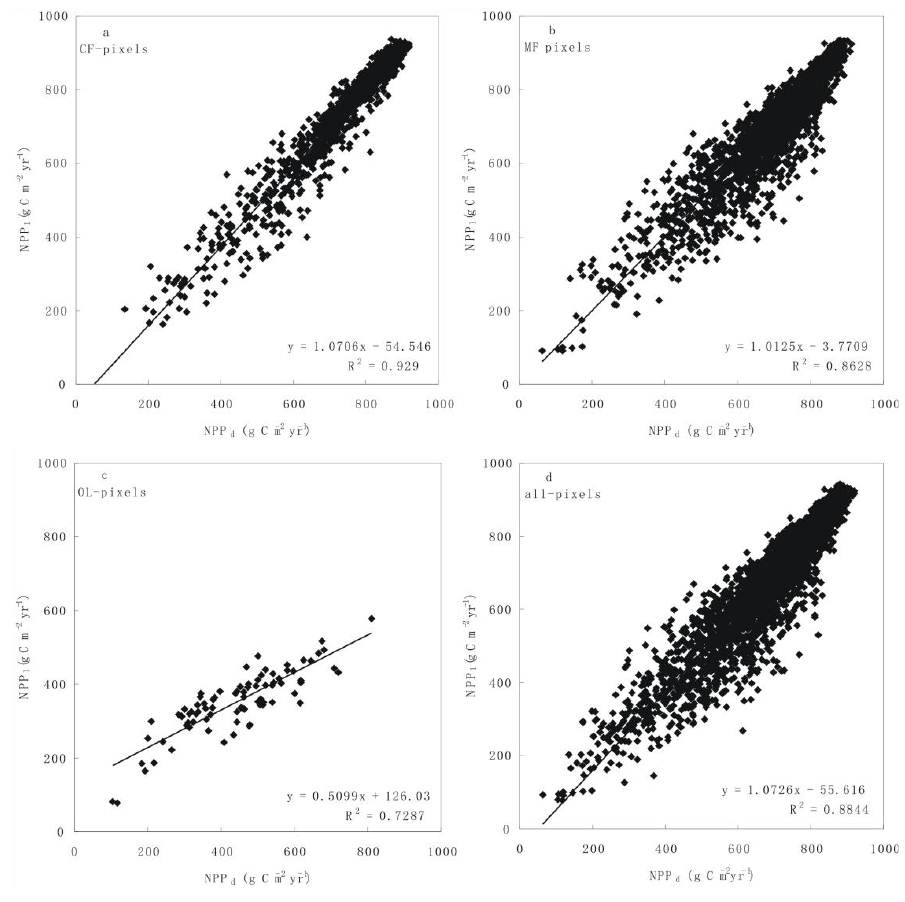
Fig. 13. Regression between distributed (NPP d ) and lumped (NPP l ) annual values after SSI correction: (a) pixels dominated by the coniferous forest (CF-pixels); (b) pixels dominated by the mixed forest (MF-pixels); (c) pixels dominated by open land (OL-pixels); and (d) all pixels for all land cover types (all-pixels).